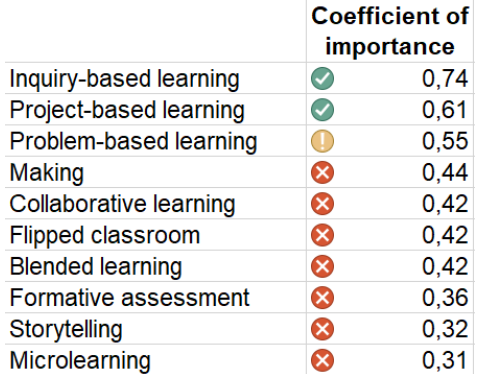
Figure 6: Survey results on the importance of innovative methods and pedagogical technologies in STEM